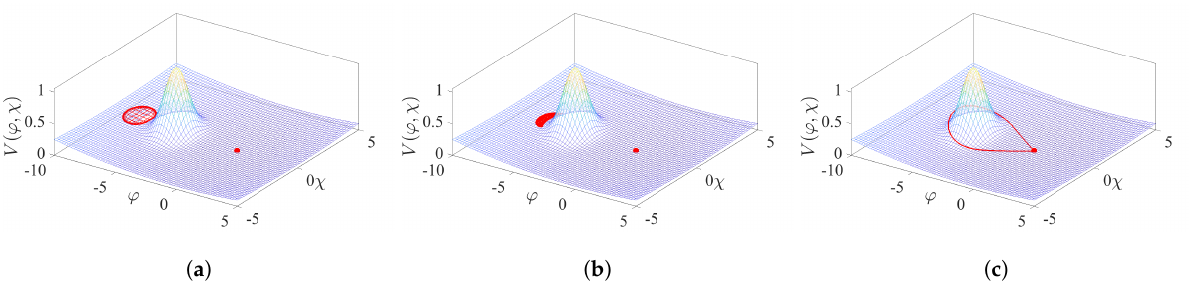
Figure 1. The potential (6) and the distribution (areas in red) of the ( ϕ , χ ) -fields for ( a ) initial, ( b ) intermediate, and ( c ) final field configurations with the final state, corresponding to the domain wall.